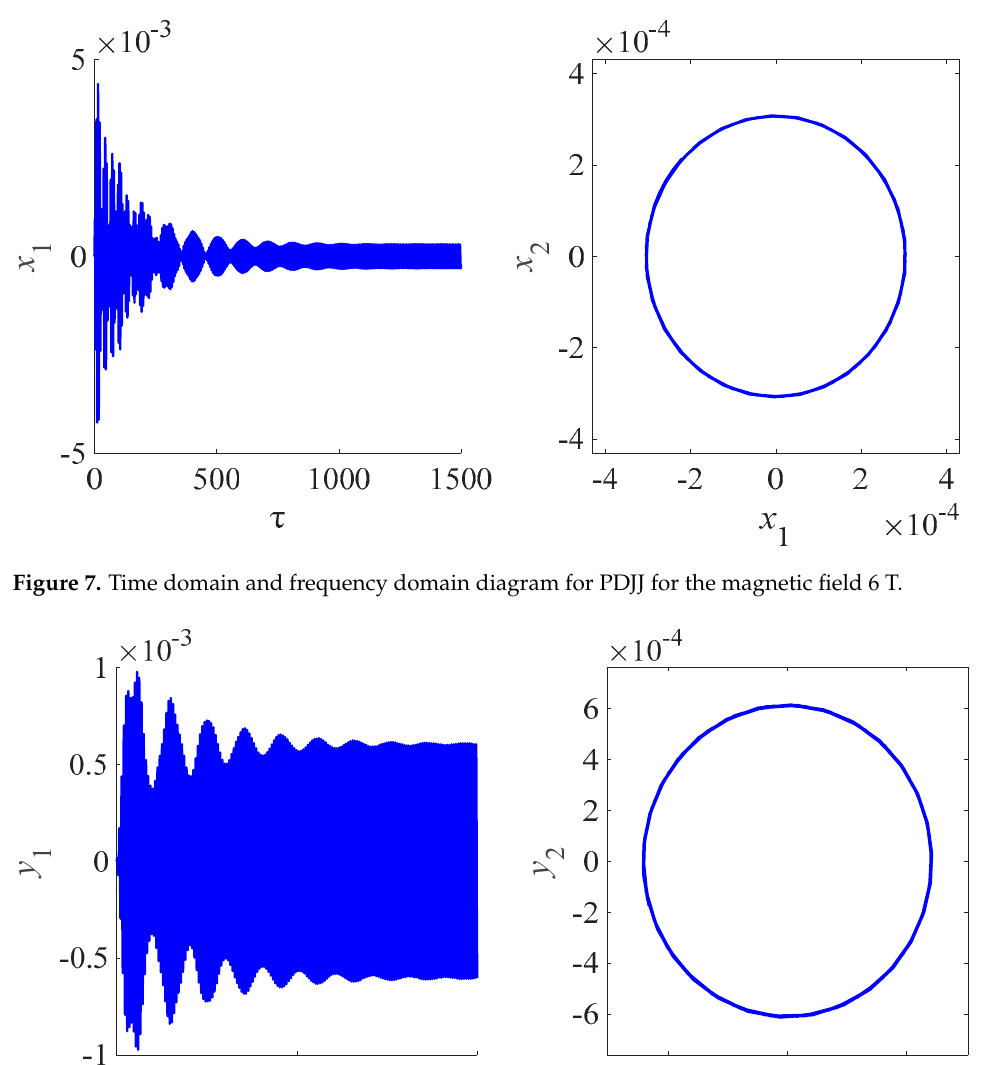
Figure 9. Time domain and frequency domain diagram for amplitude of the nanobeam for the magnetic field 6 T. Figure 10 illustrates the time domain and frequency domain diagram for ampli- tude of the nanobeam for the magnetic field 6 and 3 T. We evaluated the influence of the magnetic field intensity on the amplitudes, frequencies and modes of electrome- chanical oscillations. The amplitude of the nanobeam increases with the increase in the value of the magnetic field intensity, which is same as the conclusions as shown in Fig- ure 5.